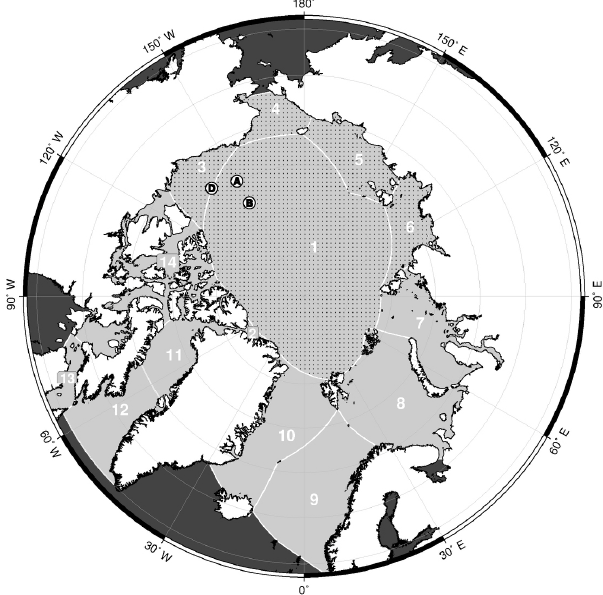
Figure 1. Regions utilized in data analysis: (1) central Arctic Ocean, (2) Lincoln Sea, (3) Beaufort Sea, (4) Chukchi Sea, (5) East Siberian Sea, (6) Laptev Sea, (7) Kara Sea, (8) Barents Sea, (9) Nor- wegian Sea, (10) Greenland Sea, (11) Baffin Bay, (12) Davis Strait, (13) Hudson Strait and (14) Canadian Arctic Archipelago. The dot- ted area represents the central Arctic region (1–6) within which all data products are available. The locations of Beaufort Gyre Explo- ration Project (BGEP) moorings A, B, and D are also indicated (white circles with mooring